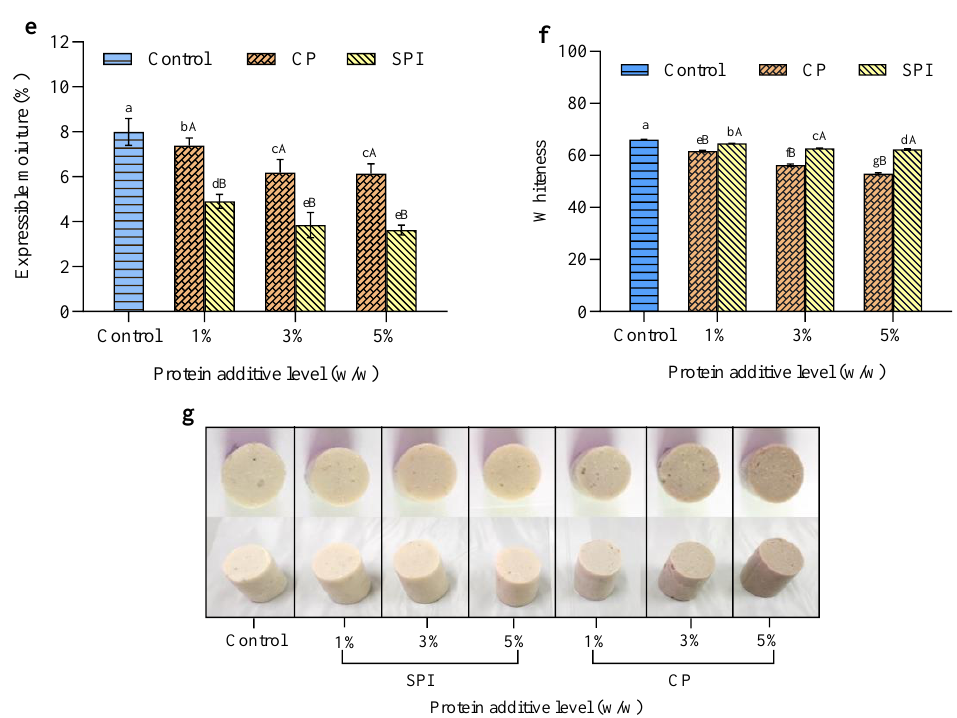
Figure 2. Effects of the addition of cricket powder (CP) and soy protein isolate (SPI) at different concentrations on TCA-soluble peptide ( a ), breaking force ( b ), deformation ( c ), gel strength ( d ), expressible moisture ( e ), whiteness ( f ), and appearance ( g ) of mackerel surimi gels. Bars represent standard deviation from triplicate determinations. Different uppercase letters between additives at the same level and different lowercase letters in all samples indicate significant differences ( p < 0.05).